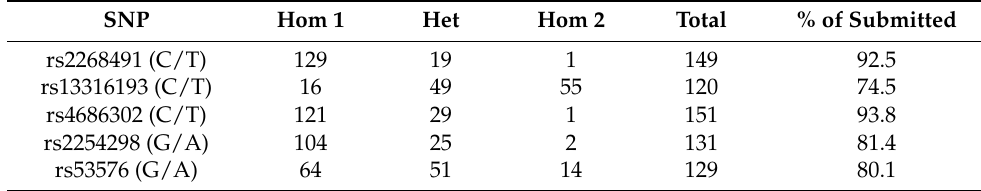
Table 1. Summary of Single nucleotide polymorphism (SNP) calling success rates. Hom (Homozygous) 1 and Hom 2 refer to the alleles as they appear under the SNPs in the table. That is, for rs2268491, C is allele 1 and T is allele 2. Hom 1 individuals at rs2268491 would be homozygous for C and Hom 2 individuals homozygous for T; Het (Heterozygous) individuals would be CT. Success rate of the assay is noted in the final column as the % of samples submitted that returned a